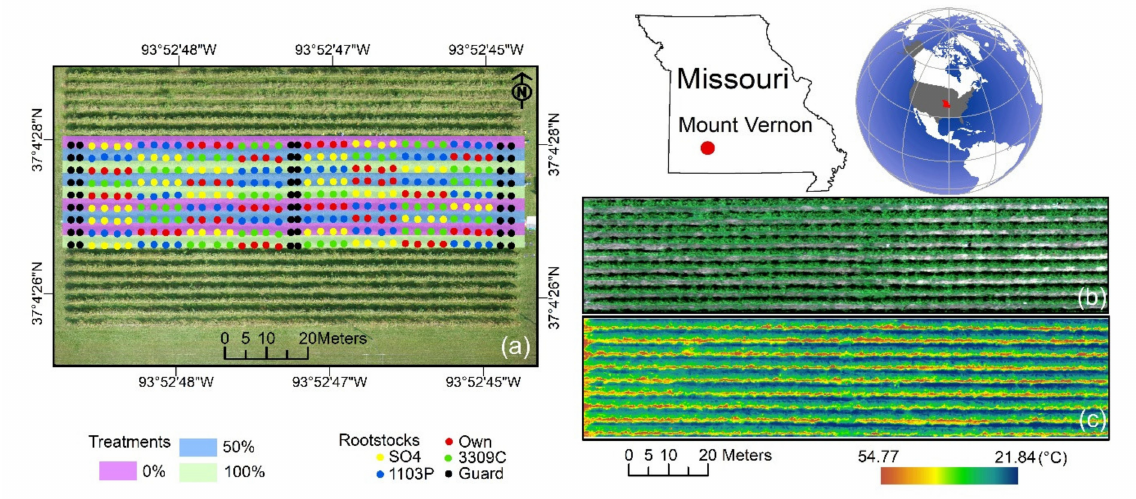
Figure 1. Central irrigation treatment rows and grapevines with di ff erent rootstocks ( a ). Figure ( b ) was obtained with a Headwall Nano hyperspectral camera (red: 659.27 nm, green: 549.27 nm, and blue: 479.69 nm, true-color image). Figure ( c ) was obtained with an ICI (Infrared Cameras Inc.) thermal